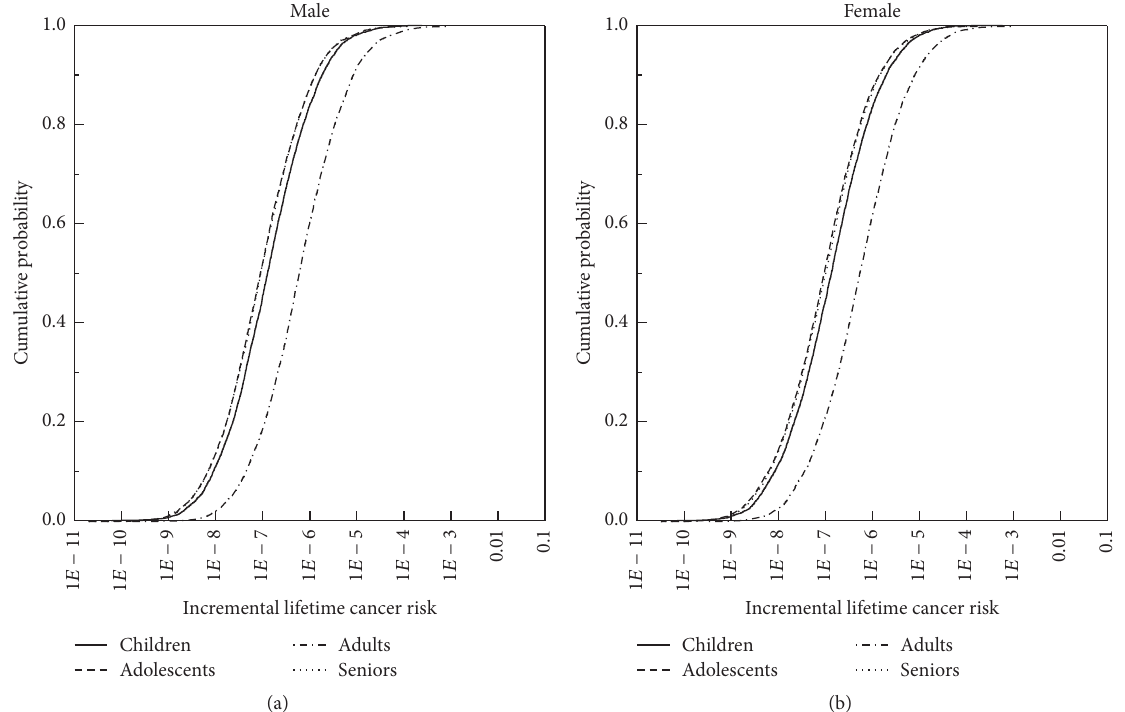
Figure 4: Cumulative probability of respiratory incremental life time cancer risk for population groups in Nanjing in